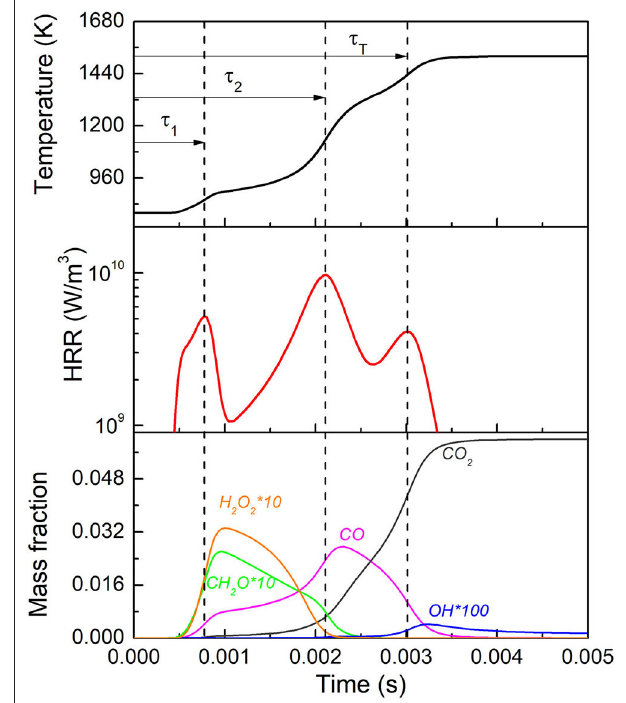
FIGURE 3 | Ignition delay, HRR and key species profile during a typical three-stage oxidation of n-heptane/air with φ = 0.3, P = 40 atm and T =